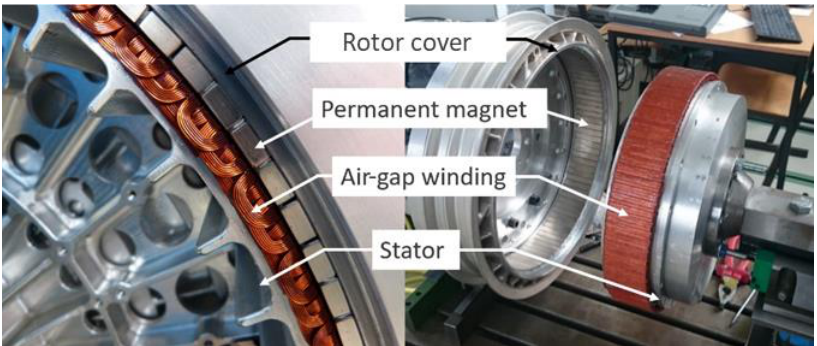
Figure 1. Basic structure of an electric machine with an applied air-gap winding.